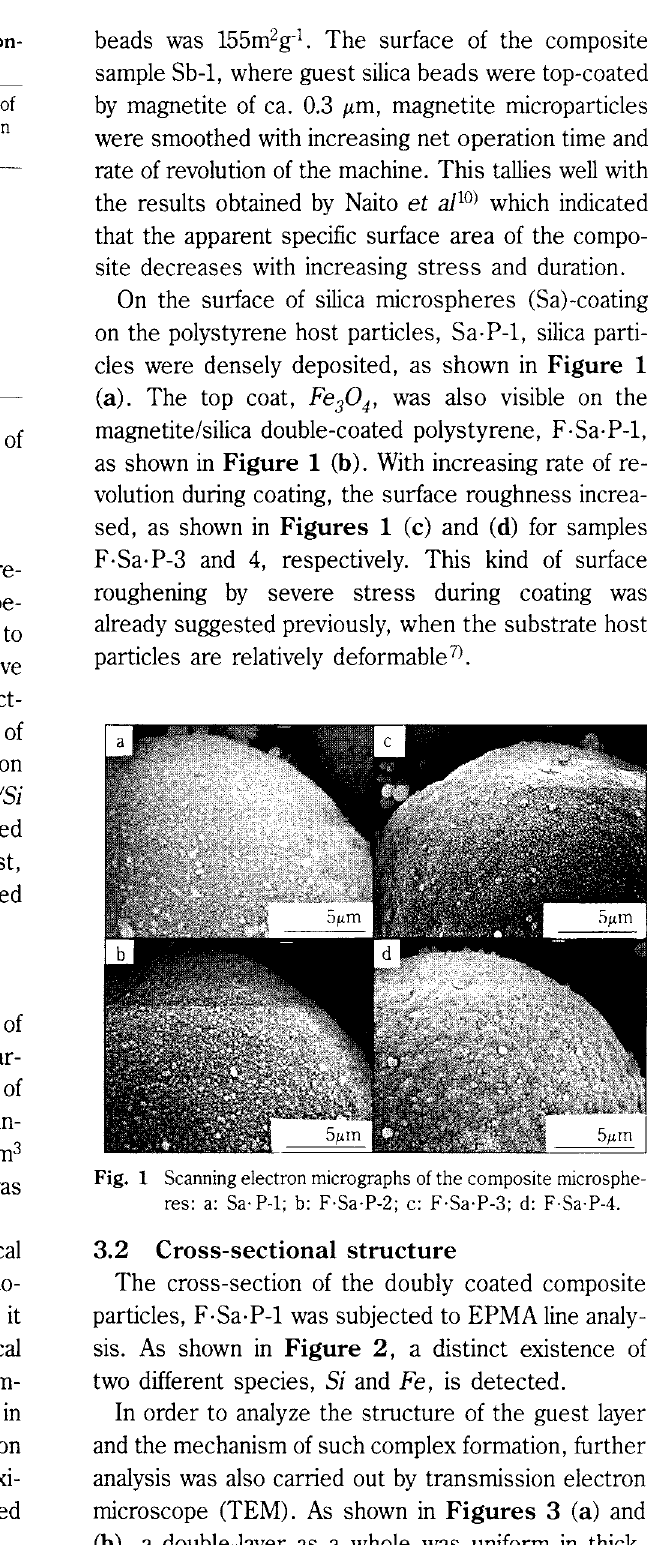
Table 2 Composite particles and their preparation con- ditions